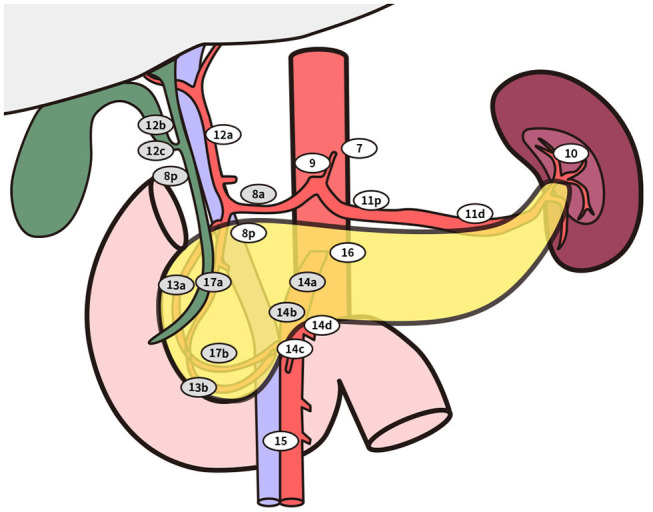
Standard lymphadenectomy. No. 5 Supra pyloric lymph nodes; No. 6 infra pyloric lymph nodes; No. 8a lymph nodes in the anterosuperior group along the common hepatic artery No. 12b lymph nodes along the bile duct; No. 12c (located next to 12b), lymph nodes around the cystic duct; No. 13a lymph nodes on the posterior aspect of the superior portion of the head of the pancreas; No. 13b lymph nodes on the posterior aspect of the inferior portion of the head of the pancreas; No. 14a-b lymph nodes along right side of superior mesenteric artery No. 17a lymph nodes on the anterior surface of the superior portion of the head of the pancreas; No. 17b lymph nodes on the anterior surface of the inferior portion of the head of the pancreas. Extended lymphadenectomy. No. 8p lymph nodes in the posterior group along the common hepatic artery; No. 12a lymph nodes along the hepatic artery; No. 12p lymph nodes along the portal vein; No. 14c-d lymph nodes along the left side of superior mesenteric artery; No. 16 lymph nodes around the abdominal aorta besides standard range of lymph node dissection.